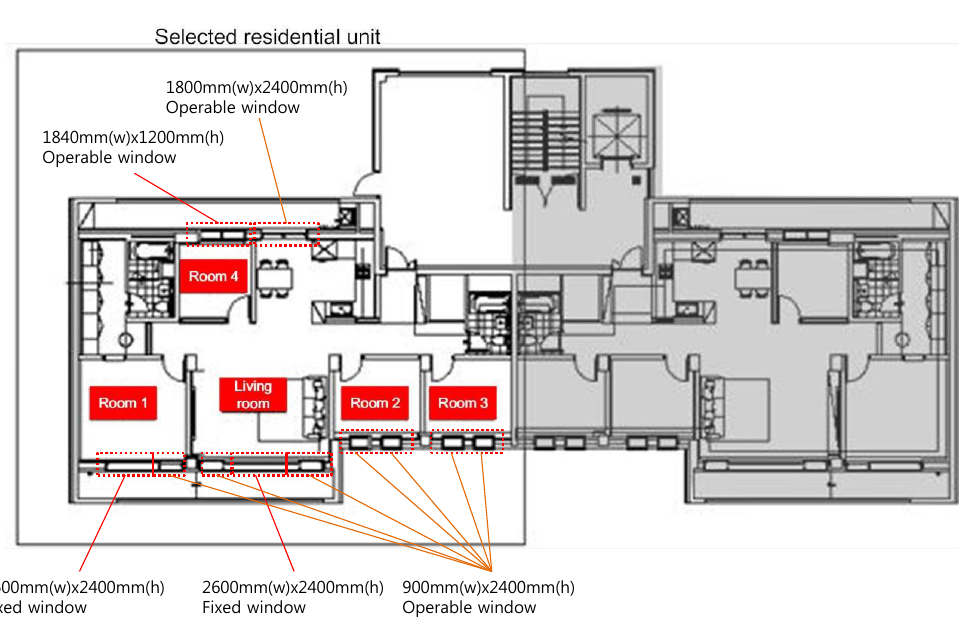
Figure 6. Selected residential unit and window geometry.